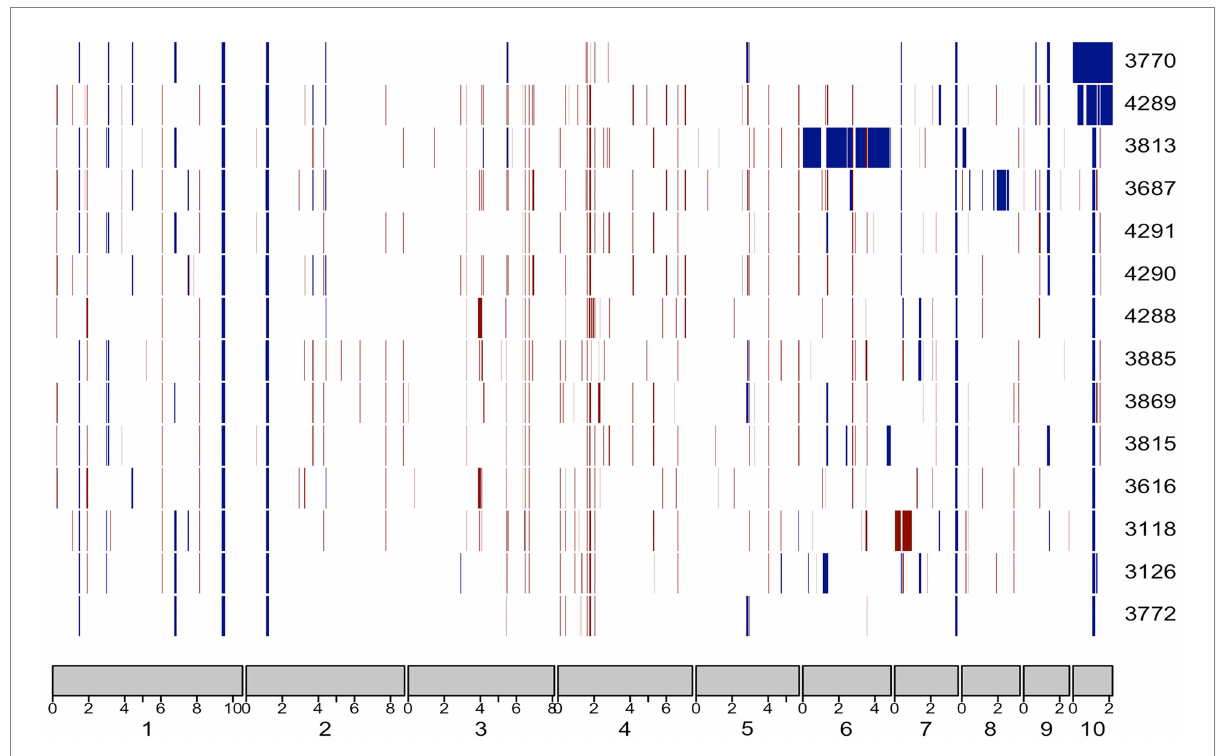
FIGURE 5 Copy number variants (CNVs) across the genomes of 14 isolates of P. agathidicida based on short read sequencing data. The rectangles at the bottom represent the ten chromosomes of P. agathidicida 3770. Tracks above depict copy number variants, where blue rectangles indicate duplications and red rectangles indicate deletions. P. agathidicida isolate numbers are displayed on the